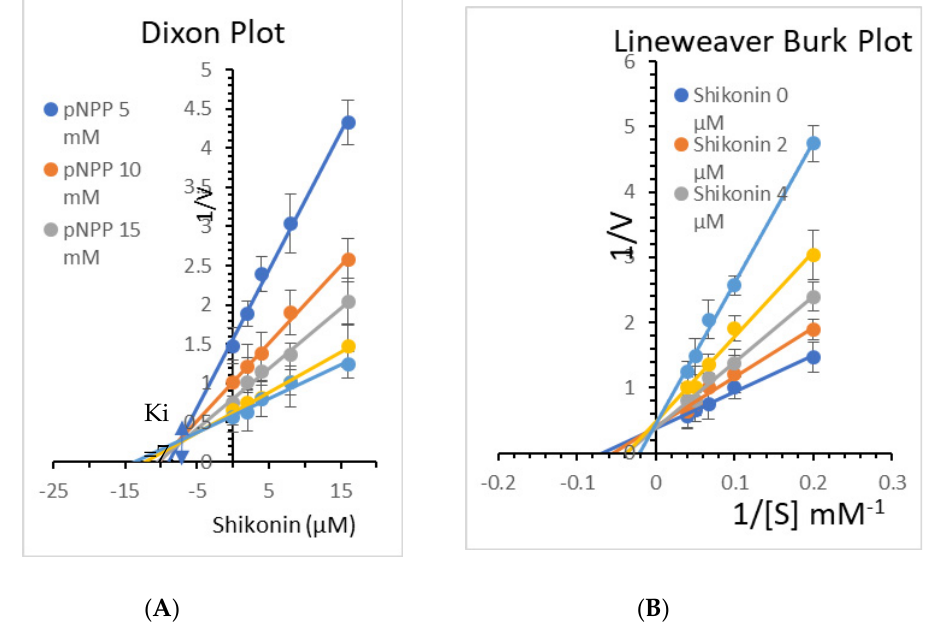
Figure 13. ( A ) Dixon plots of protein tyrosine phosphatases 1B (PTP1B) inhibition by Shikonin at various substrate (pNPP) concentrations (5, 10, 15, 20, and 25 mM). ( B ) Lineweaver–Burk plot for inhibition of PTP1B by Shikonin was analyzed in the presence of different concentrations of Shikonin (0, 2, 4, 8, and 16 µ M).